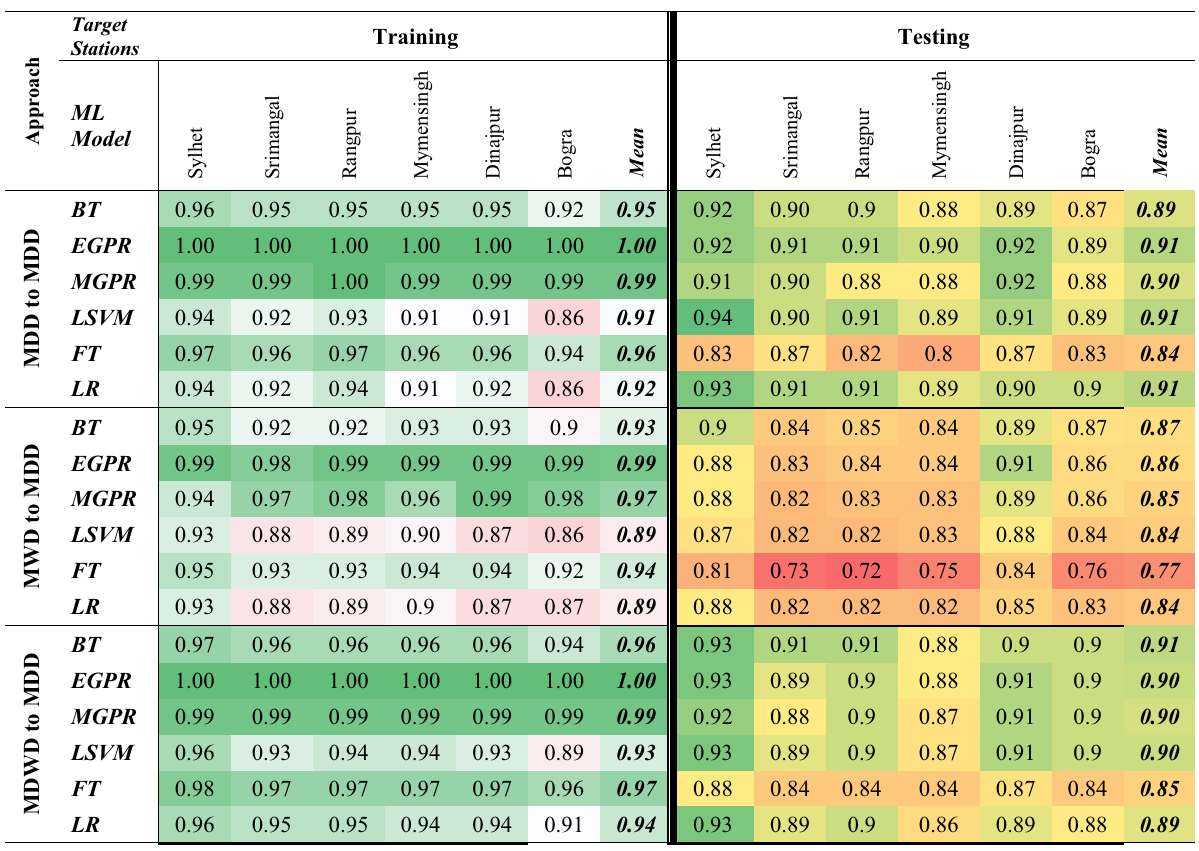
Table 1. Values of R 2 from the ML models for the approaches (1) MDD to MDD (2) MWD to MDD & (3) MDWD to MDD. Significant values are in bold and